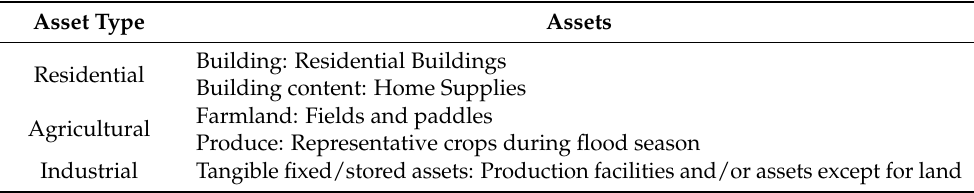
Table 2. Flood Damage Assets by Administrative District Based on the